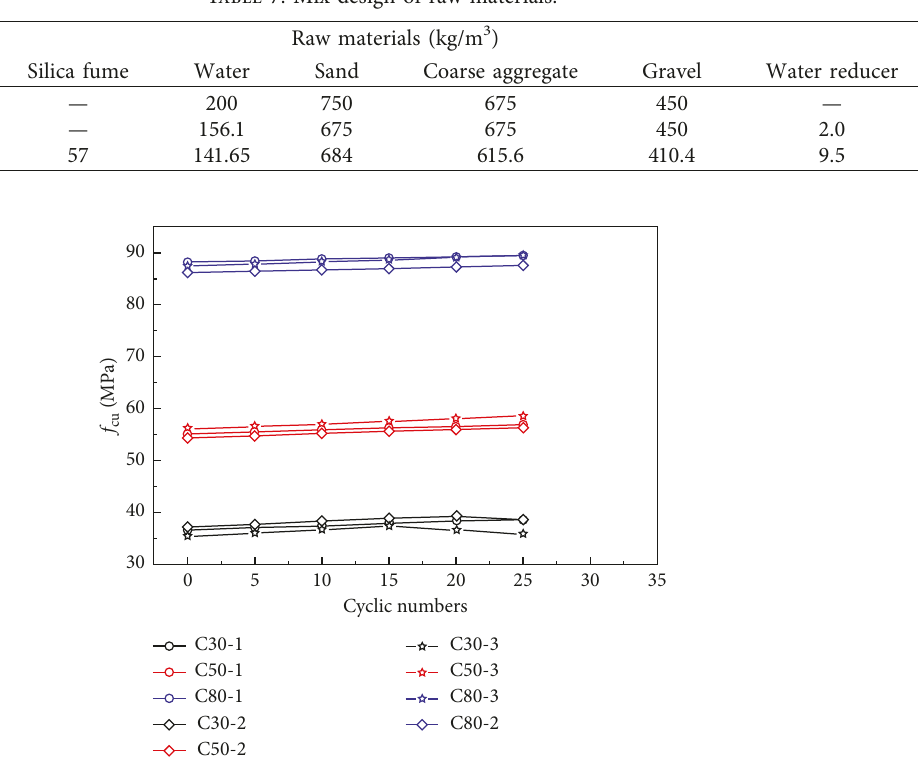
Figure 9: Compressive strength of concrete exposed to cyclic